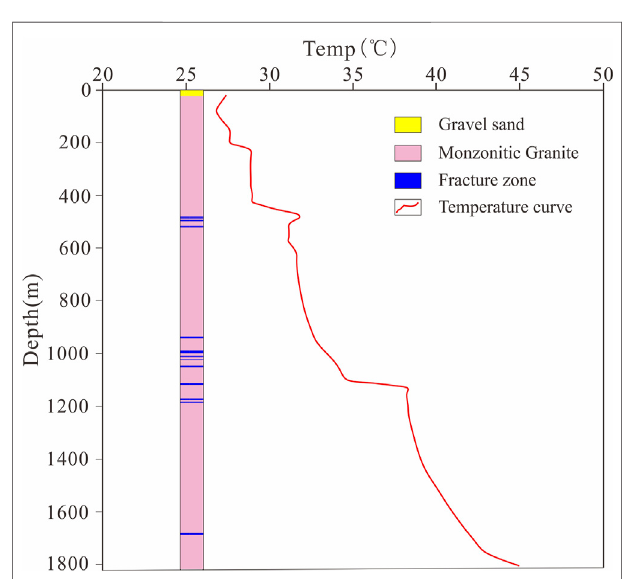
FIGURE 13 | Temperature logging and lithology for the Zangnan well (No. 14 in Figures 6 , 7